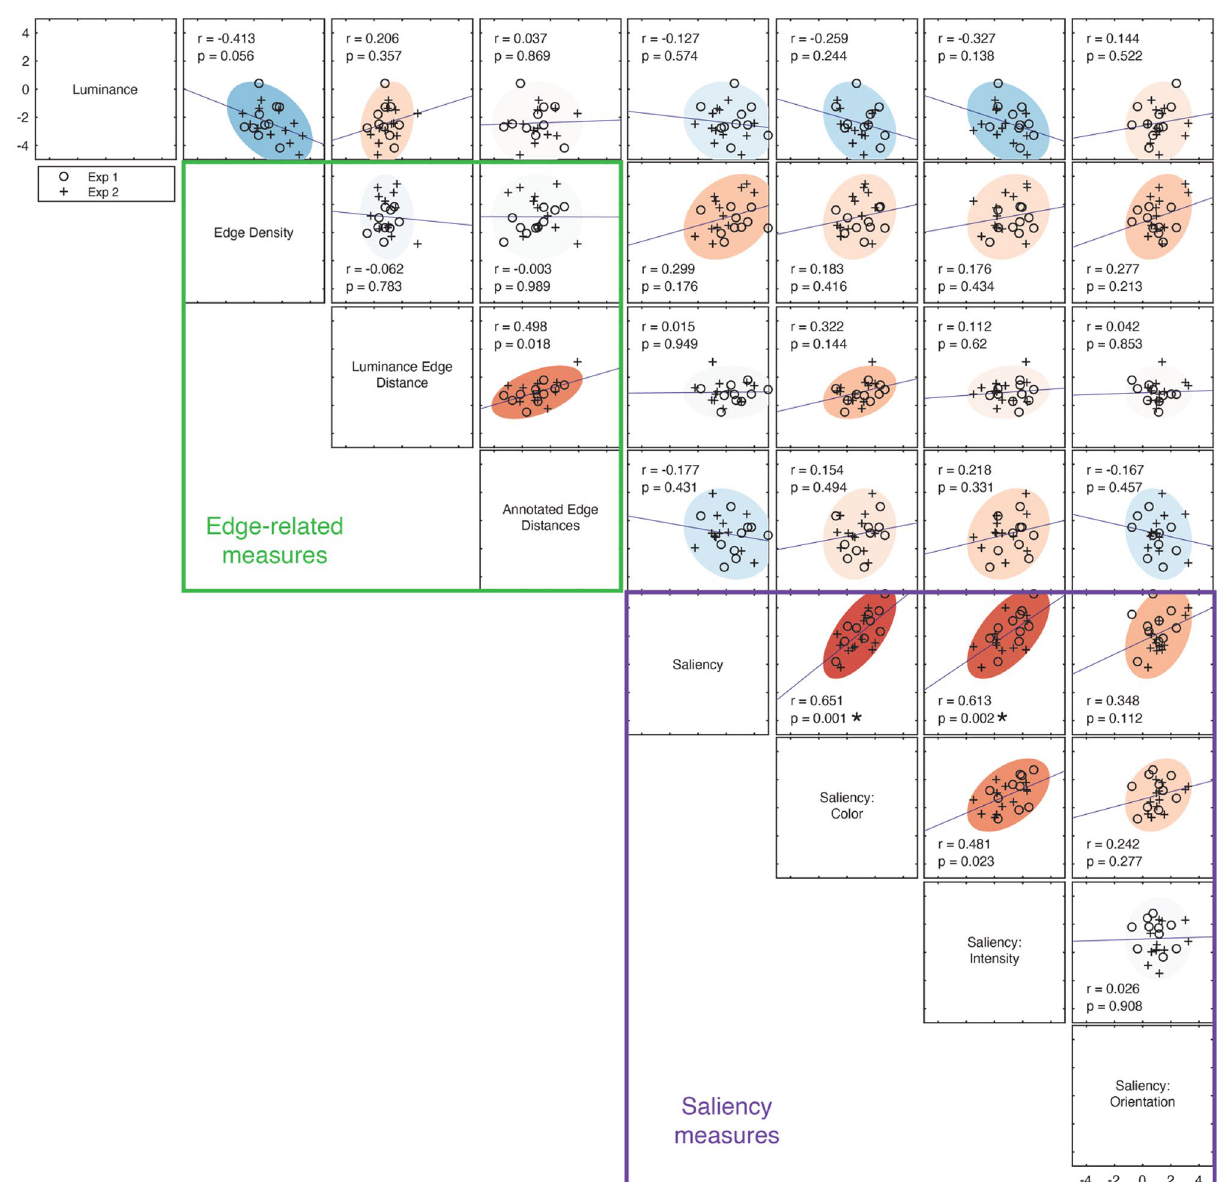
Experiments 1 (empty circle) and 2 (plus symbol). The correlations for Experiment 3, which used color negative images, are shown separately in Fig. 6. Filled oval regions represent 95% error ellipses, using the same